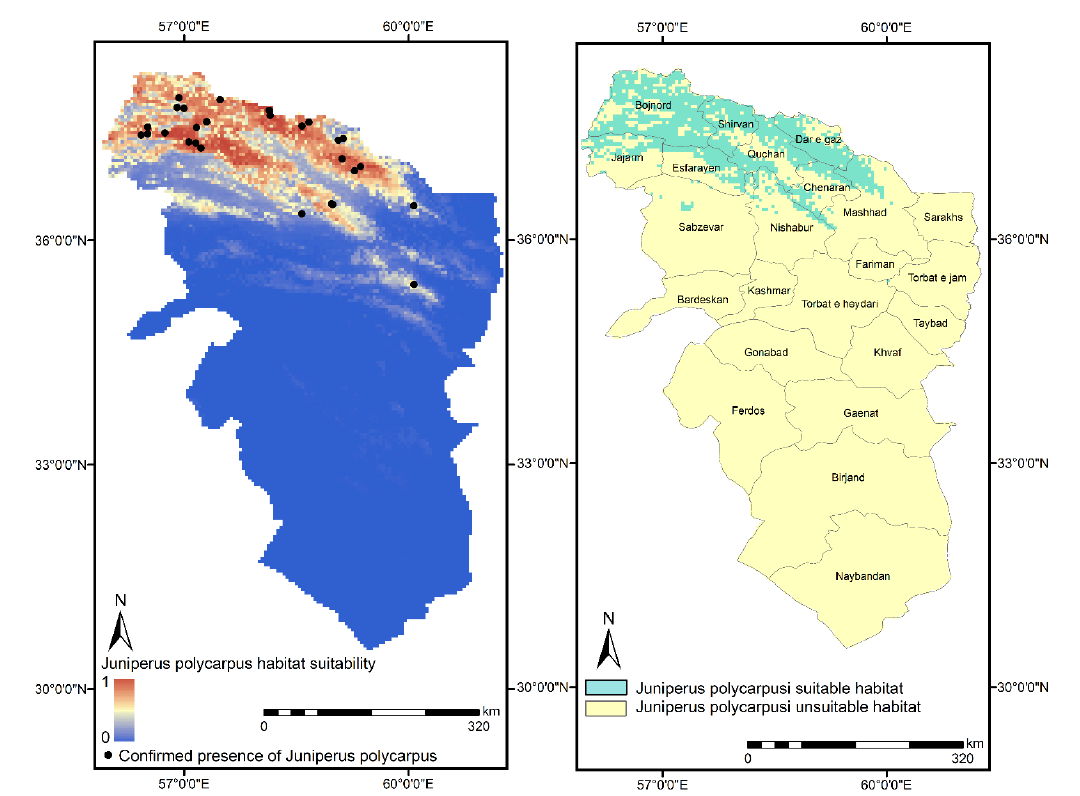
Fig. 2: Habitat suitability of Juniperus polycarpus and its suitable habitats in the cities of Khorasan